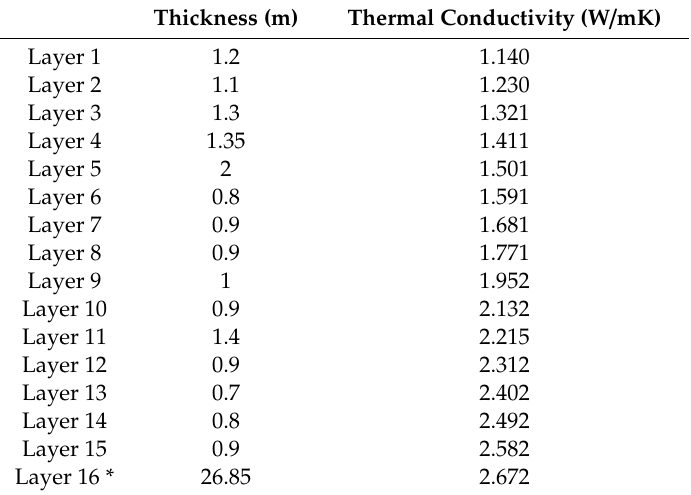
Table 4. Di ff erent thermal conductive layers identified in the volume of ground located under the borehole identified for this